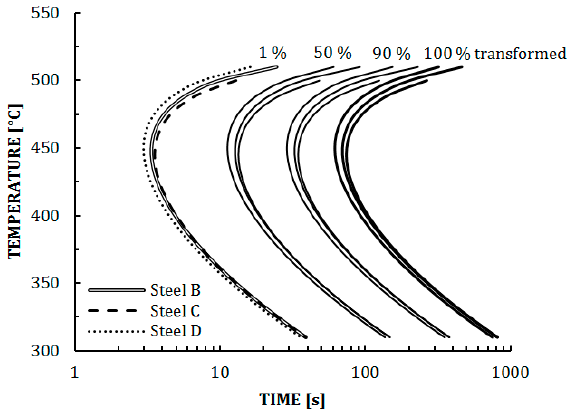
Figure 1. Time–temperature transformation (TTT) curves for the bainitic transformation of experimental steels.